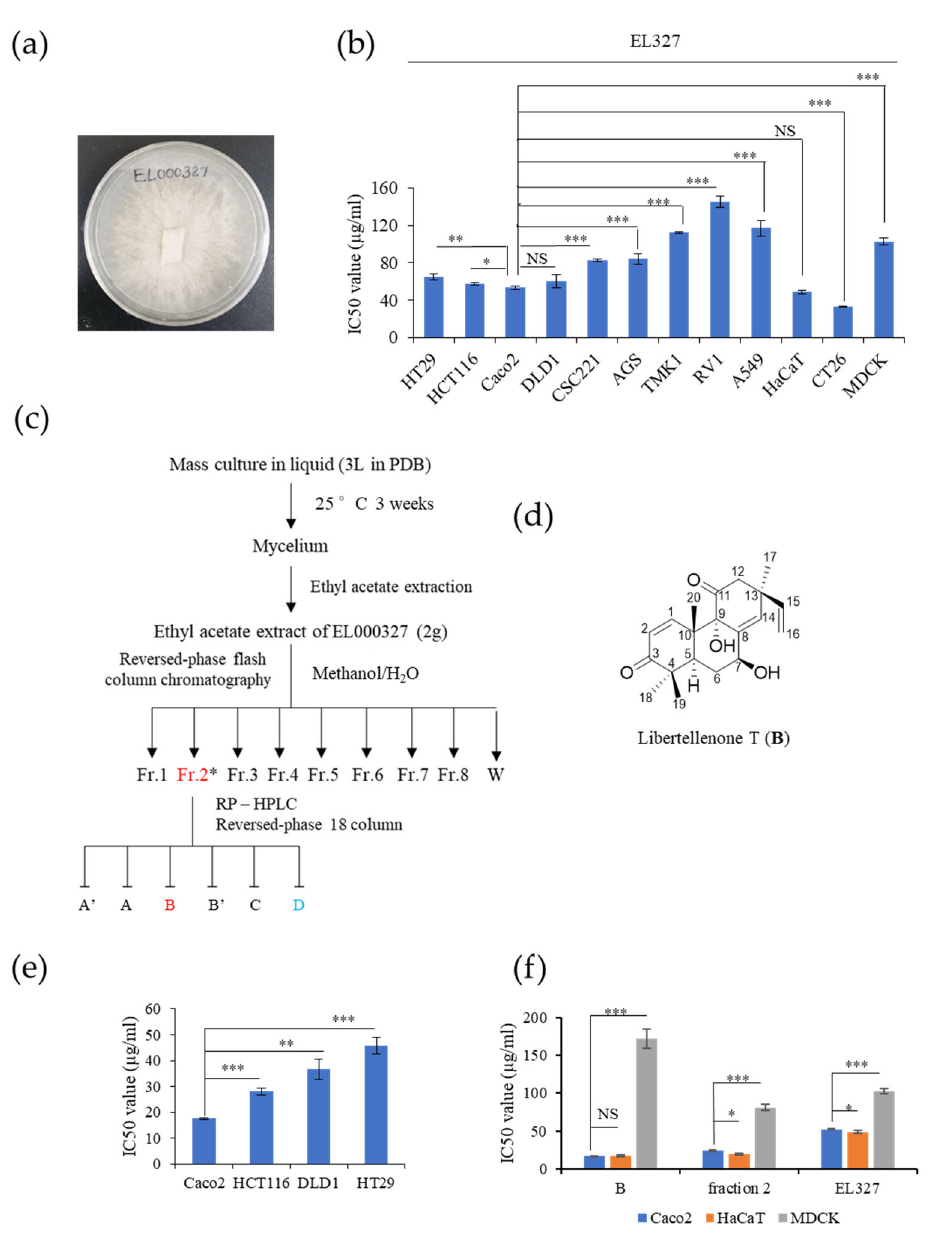
Figure 1. Compound B isolated from the crude extract of EL000327 exhibited cytotoxicity toward the human CRC cell line, Caco2. ( a ) Image of the endolichenic fungus, EL000327, belonging to Pseudo- plectania sp. isolated from the lichen Graphis. ( b ) IC 50 values of EL000327 in HT29, HCT116, Caco2, DLD1, CSC221, TMK1, RV1, A549, HaCaT, CT26, and MDCK cells. ( c ) Schematic representation of the process for the purification of compound B from the crude extract, EL000327. ( d ) Chemical structure of the novel compound, B . ( e ) IC 50 values of human CRC cells Caco2, HCT116, DLD1, and HT29 after treatment with B for 48 h. ( f ) Comparison of IC 50 values of the CRC cells Caco2 and non-cancer cell lines HaCaT and MDCK treated with single compound B , fraction 2, or crude extract, EL000327 for 48 h. Results are representative of three independent experiments. Data represent the mean ± S.D. * p < 0.05, ** p < 0.01, *** p < 0.001, NS: no significant difference ( p > 0.05) compared with the Caco2